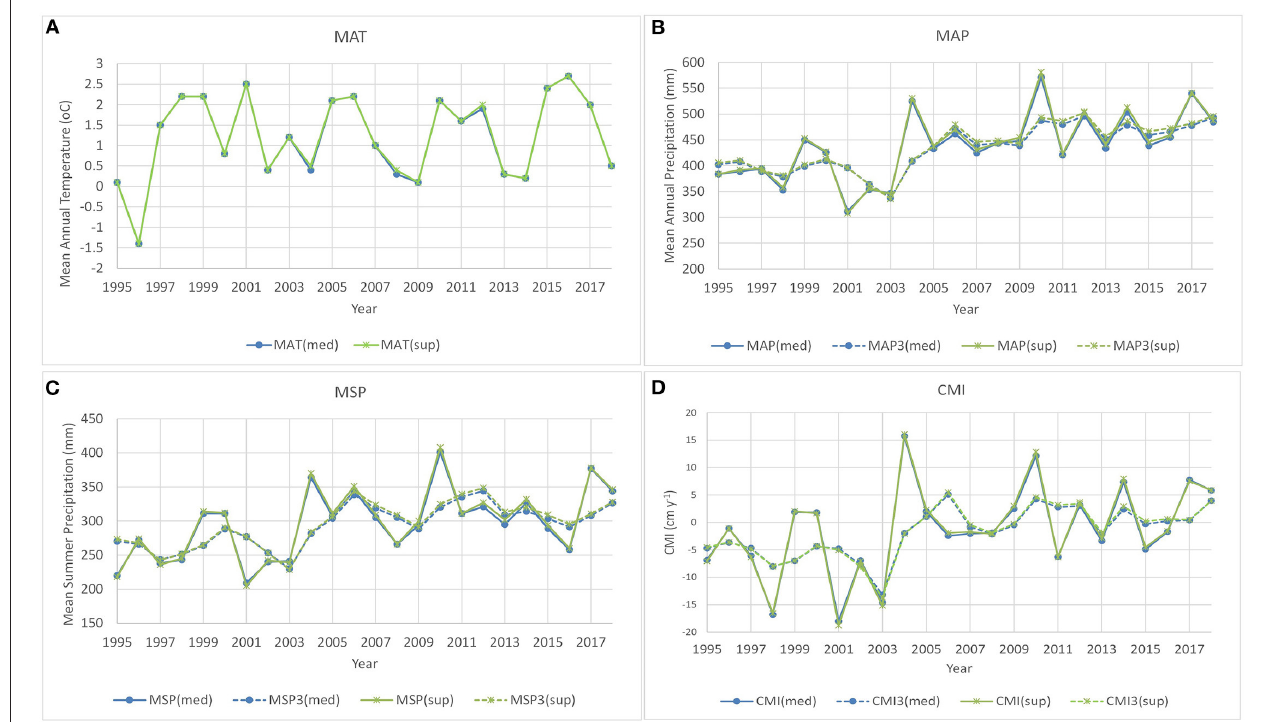
FIGURE 3 | Trends in (A) mean annual temperature (MAT), (B) mean annual precipitation (MAP) and 3 year running average of mean annual precipitation (MAP3), (C) mean summer precipitation (MSP) and 3 year running average of mean summer precipitation (MSP3), and (D) climate moisture index (CMI) and 3 year running average CMI (CMI3) for the two Big River installations (med, median; sup, superior).